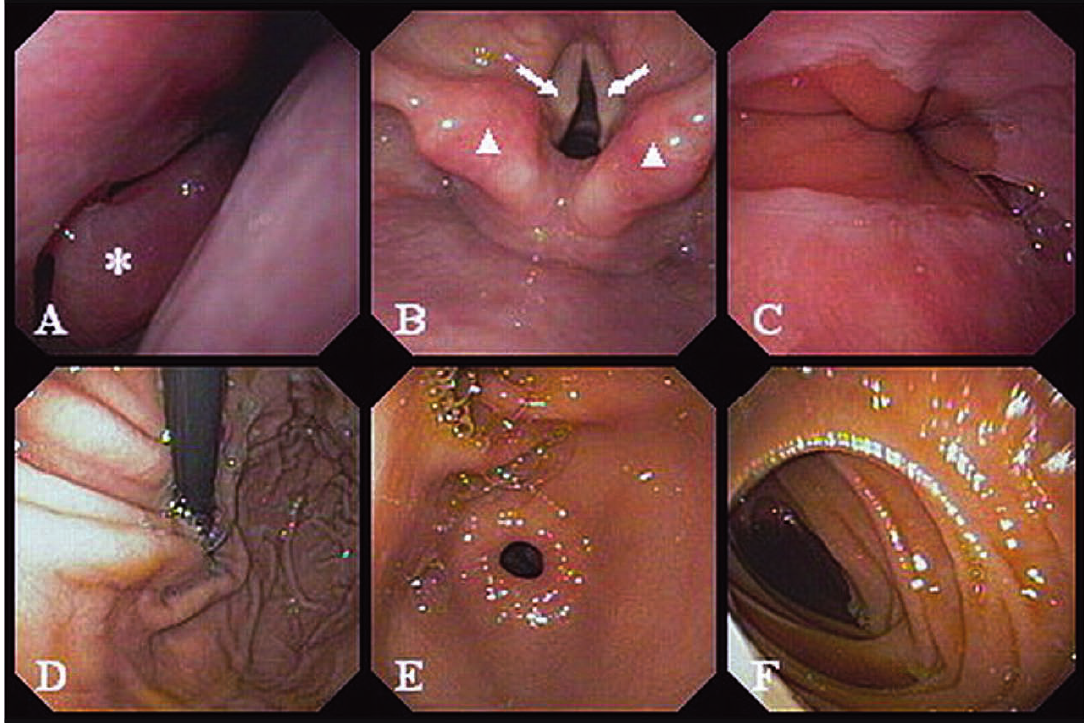
Figure 1 Transnasal-eGd. A. Nasal cavity (*, inferior nasal concha); B. larynx ( ▲ , ary- tenoids; arrows, vocal cords); C. Oesogastric mucosal junction; d. Gastric fundus, retroflexion view. e. Gastric antrum. F. Second portion of the